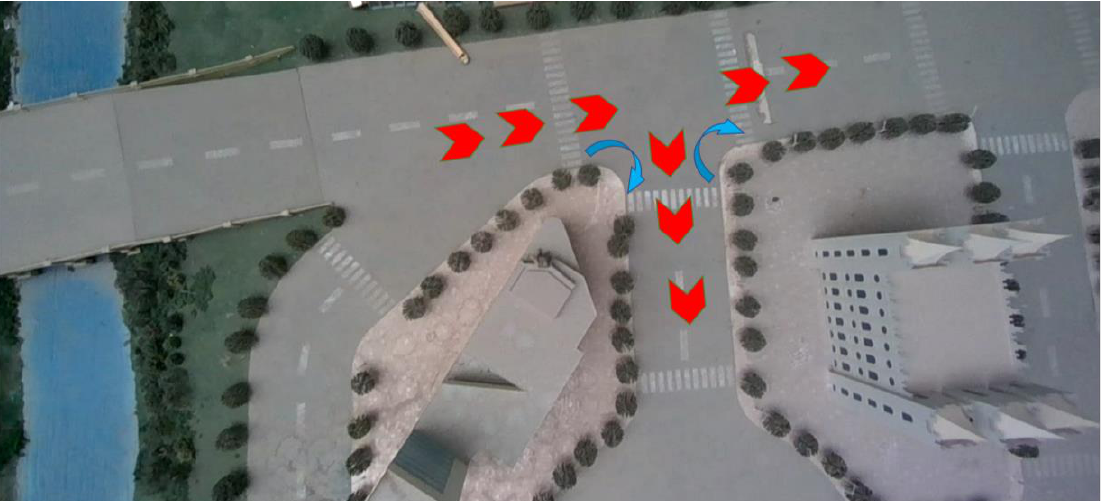
Figure 11. Top view of the running path. The red arrows indicate the traveling direction of the car, and the blue arrows indicate the turning direction of the car.